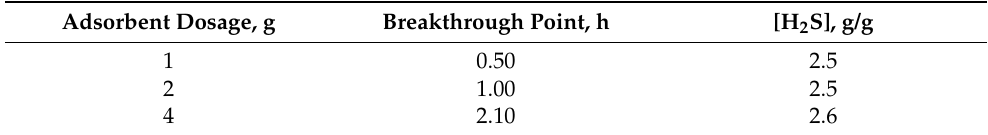
Table 1. H 2 S loading at the breakthrough point using various adsorbent dosages.